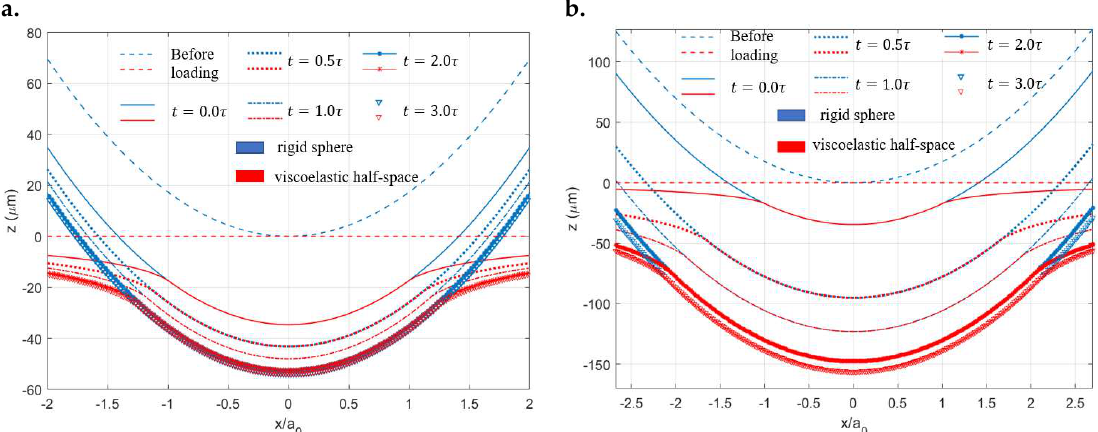
Figure 9. Creep of surface profiles at different time points for different viscoelastic materials: ( a ) (cid:3091) (cid:3246) = 2 and ( b ) (cid:3091) (cid:3246) = 10 .